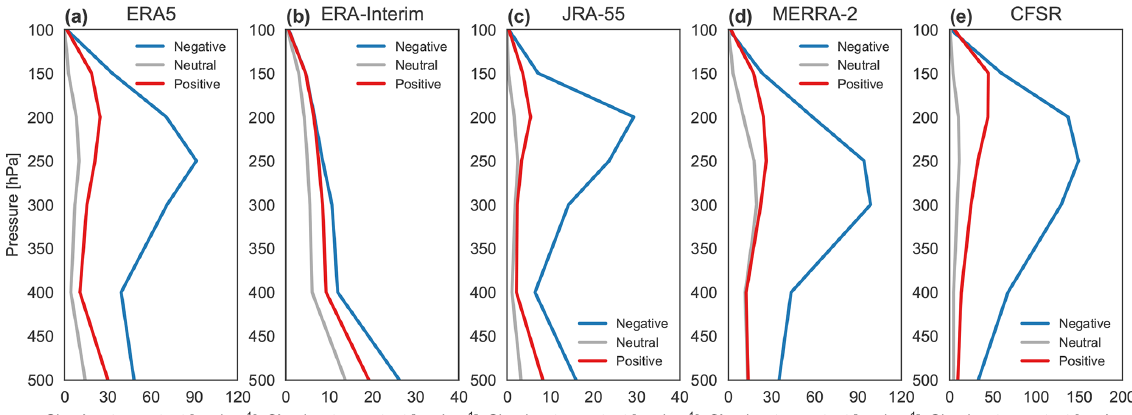
Figure 13. Composite mean profiles of cloud water content (CWC) from (a) ERA5, (b) ERA-Interim, (c) JRA-55, (d) MERRA-2, and (e) CFSR associated with different ranges of radiative heating rates at 150hPa: negative rates less than − 1Kd − 1 (blue), neutral rates within ± 1Kd − 1 (grey), and positive rates greater than + 1Kd − 1 (red). Note different x axis ranges for